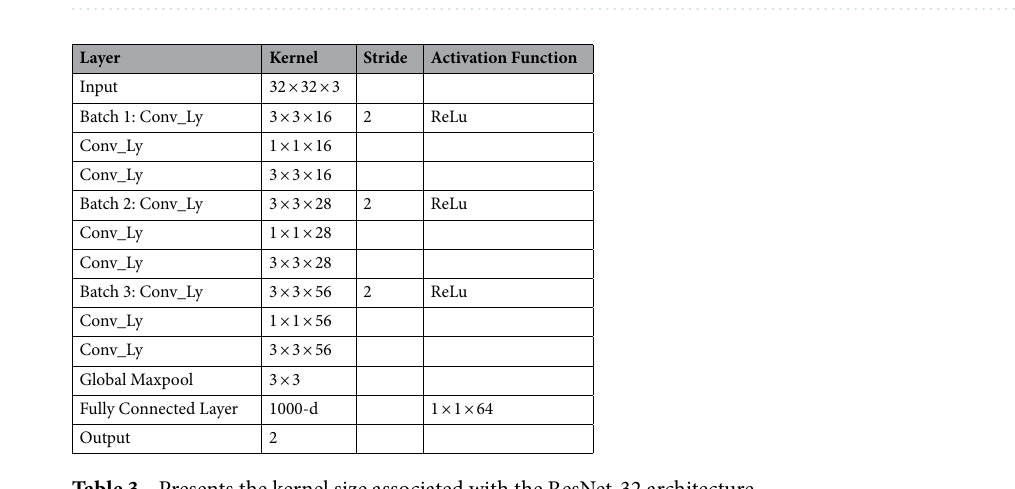
Figure 7. Presents the layered architecture of ResNet-32 for classification.